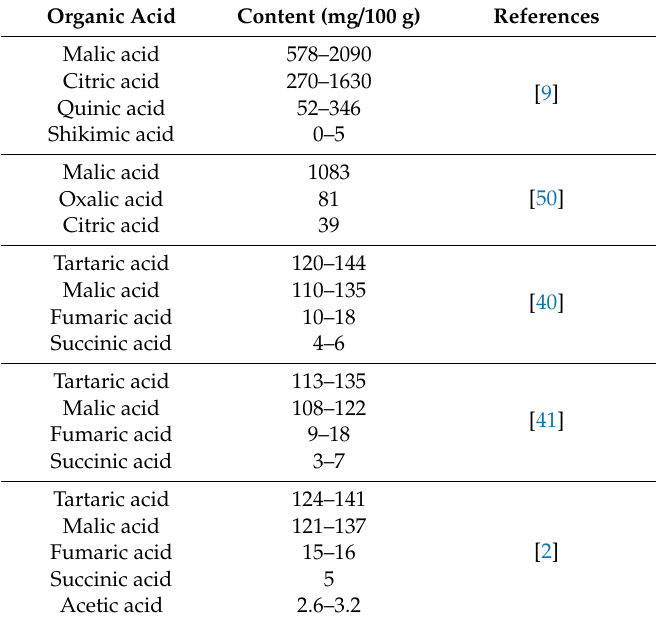
Table 1. Content (mg / 100 g fresh weight) of individual organic acids in Viburnum opulus fruits. Organic